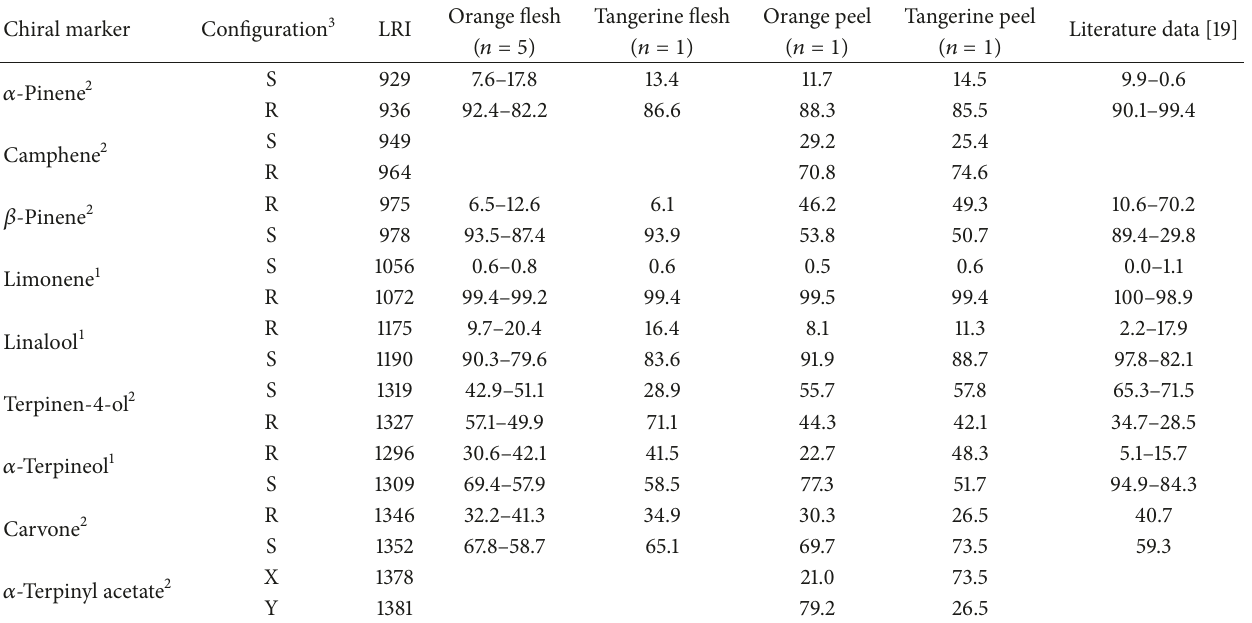
Table 5: Chiral markers, calculated LRI, and corresponding enantiomeric ratios for orange and tangerine fibres. Chiral